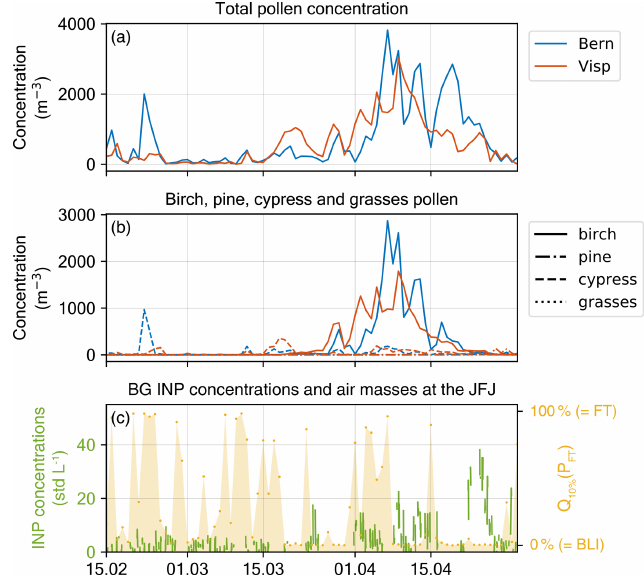
Figure A1. Timeline of the total pollen concentration at Bern and Visp (a) , of the dominant species (b) and the corresponding high-resolution INP concentration at JFJ and the Q 10% of P FT of a given day (c) between 15 February and 1 May 2020. Pollen data courtesy of MeteoSwiss.